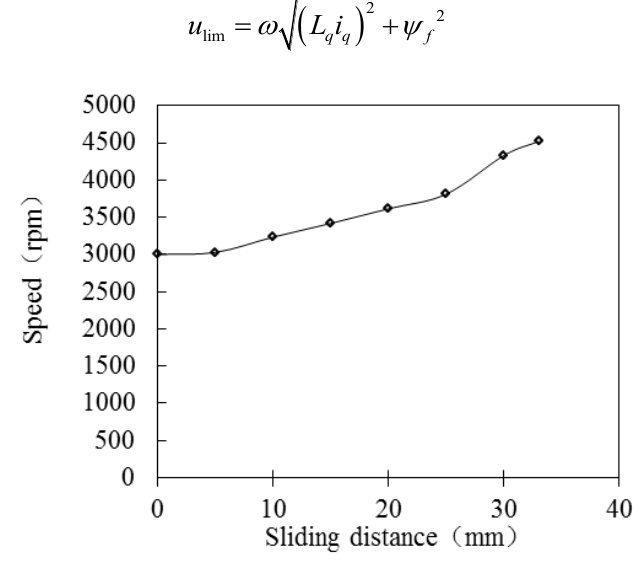
Figure 16. Relationship between the speed and the PMs sliding